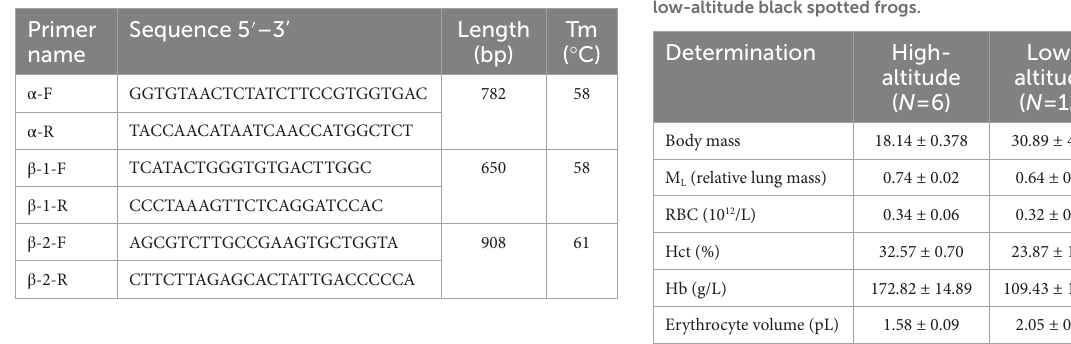
TABLE 1 Primer sequences for PCR